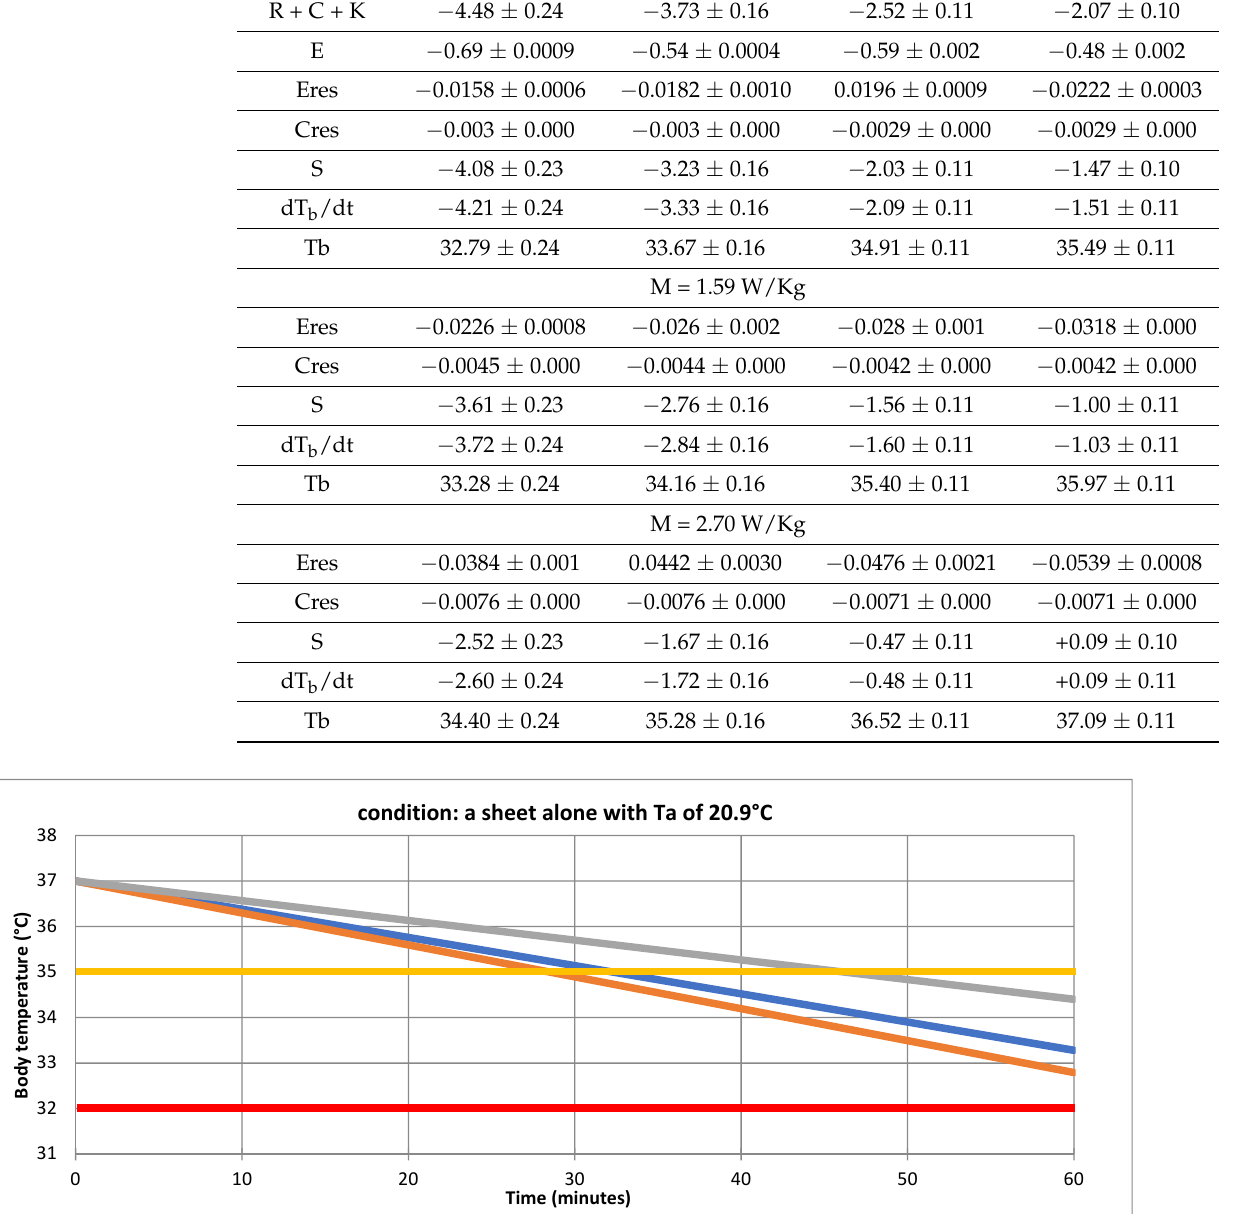
Table 2. The mannequin’s dry heat losses (R + C + K), evaporative heat losses from the respiratory tract (Eres) and the skin (E), and convective respiratory heat loss (Cres) at three different values of M. S is the body heat storage. Heat transfers and S are expressed in W/kg. dT b /dt is the change in the mean body temperature ( ◦ C/h). T b is the mean body temperature change calculated after an hour of SSC ( ◦ C) and an internal body temperature of 37 ◦ C at birth. Only the values of C res and E res (which depend on energy metabolism; see Equations (2) and (3)) differed; the magnitudes of the other factors (R, C, K, and E) involved in the heat storage calculation remained the same. Ta 20.9 ◦ C 25.9 ◦ C Conditions Sheet Sheet + Blanket Sheet Sheet + Blanket